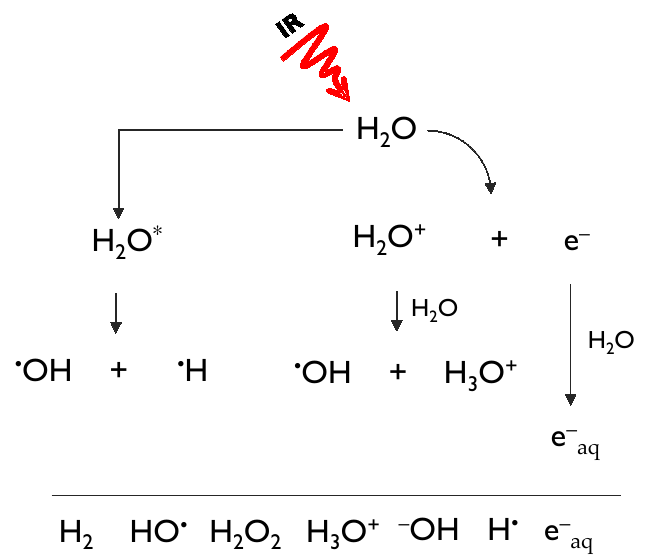
Figure 1. Hydrated electrons (e − aq ), and radical and molecular species generated during water hydrolysis.